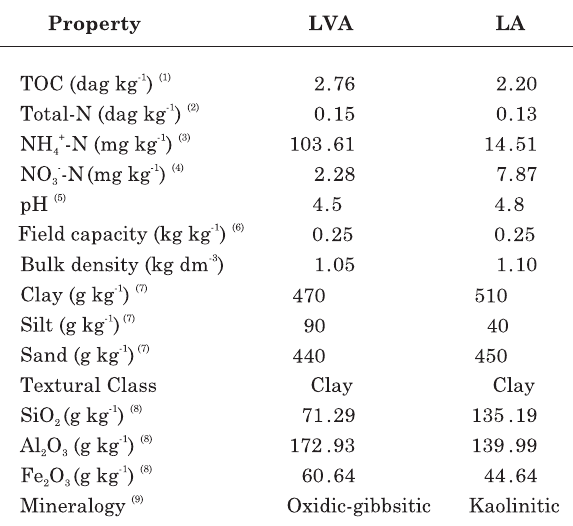
(1) Total Organic Carbon (Yeomans & Bremner, 1988). (2) Total nitrogen (Bremner & Mulvaney, 1982). (3) Ammonium nitrogen (Kempers & Zweers, 1986). (4) Nitrate nitrogen (Yang et